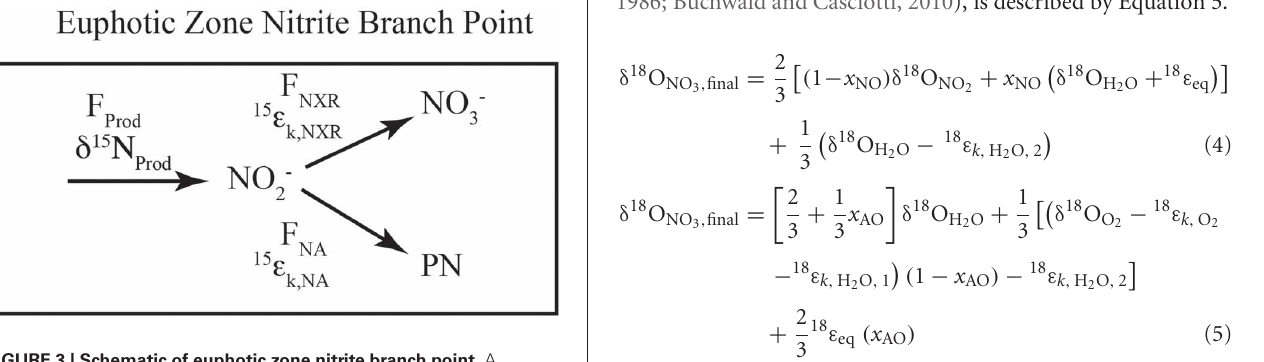
FIGURE 3 | Schematic of euphotic zone nitrite branch point. A schematic of the fluxes and isotope effects involved with NO − 2 consumption in the euphotic zone. NO − 2 is produced (F prod , δ 15 N prod ) from ammonia oxidation and/or nitrate reduction, the mixture of which sets the incoming flux and δ 15 N value. NO − 2 consumption can occur through nitrite oxidation (F NXR , 15 ε k , NXR ) or nitrite assimilation by phytoplankton (F NA , 15 ε k , NA ). The relative rates of uptake vs. oxidation dictate the partitioning between NO − 2 and NO − 3 relative to the source(s) of NO − 2